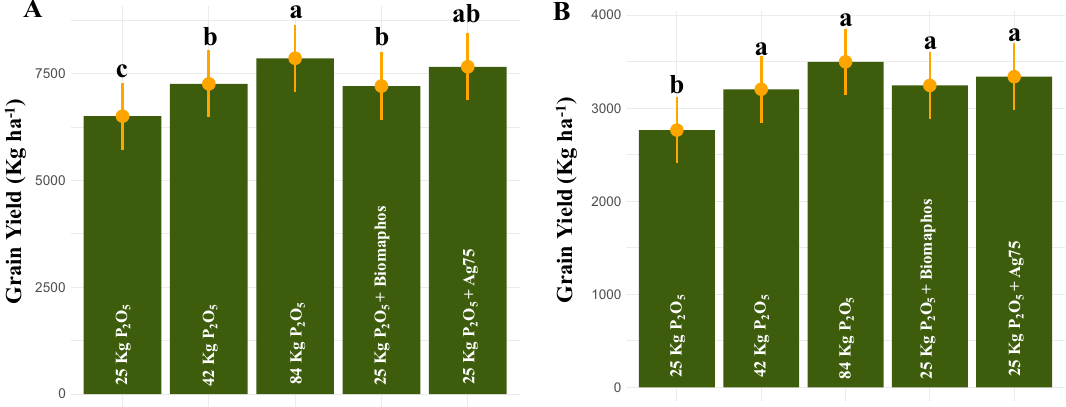
Figure 2. Effect of phosphate solubilizing bacteria on grain yield in maize ( A ) and soybean ( B ) experiments.